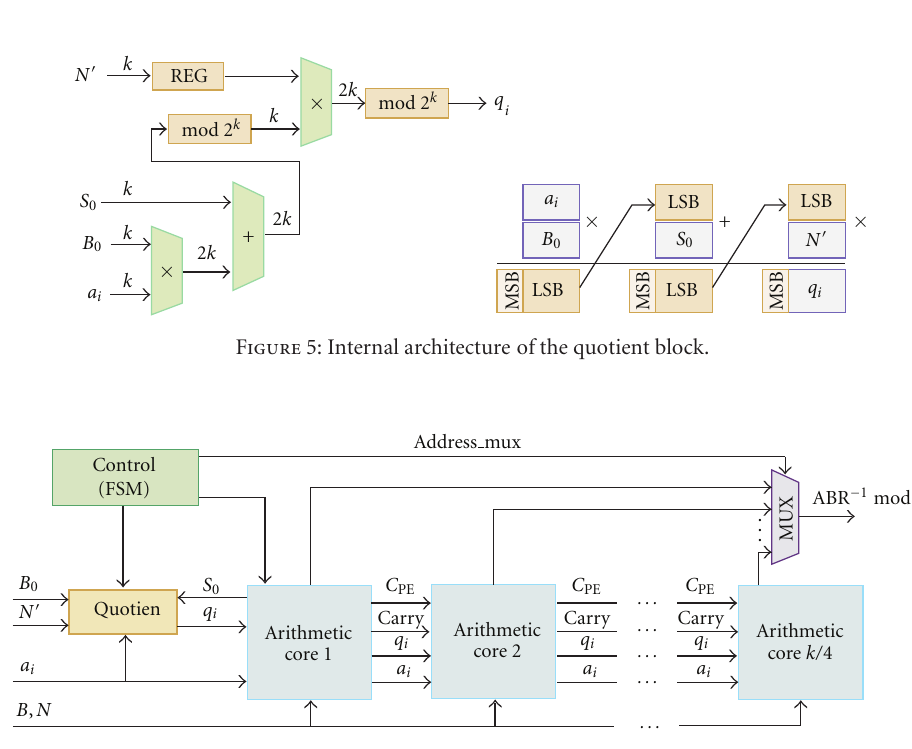
Figure 6: Proposed multiplexed modular multiplication